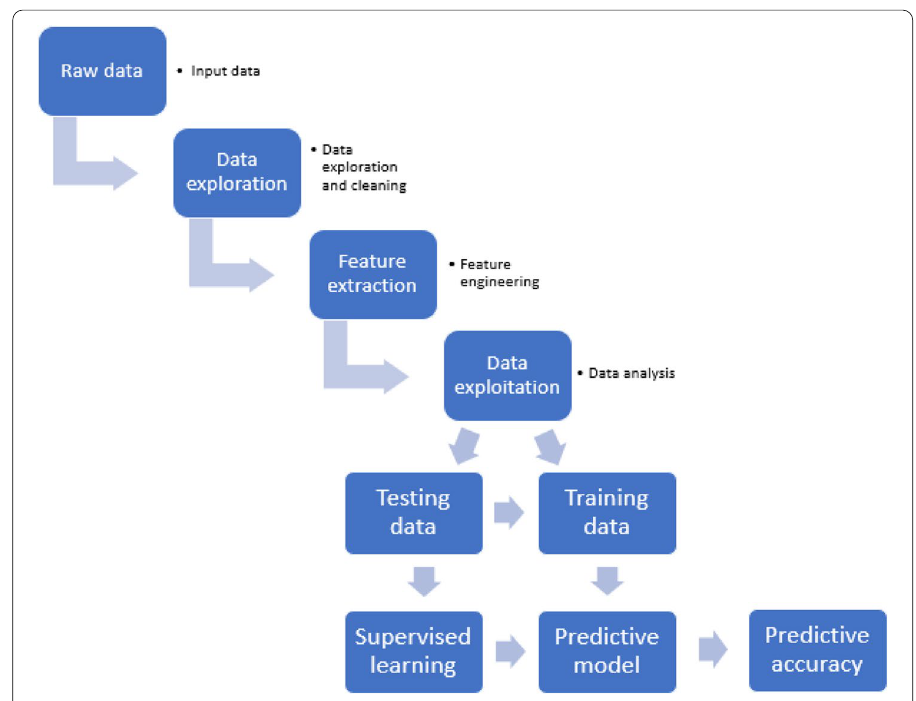
Fig. 1 The proposed predictive model for diabetes emergency